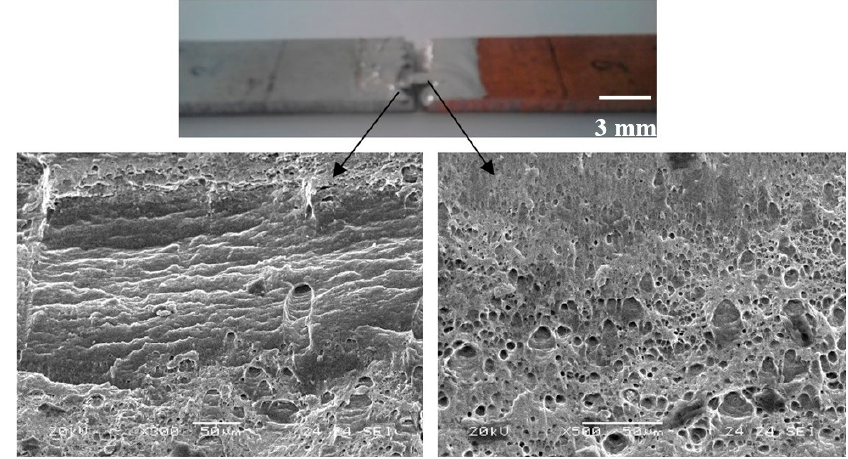
Figure 10. Surface images after tensile tests and SEM images of ruptured surface of welded joints in the 630/50/1 specimen.